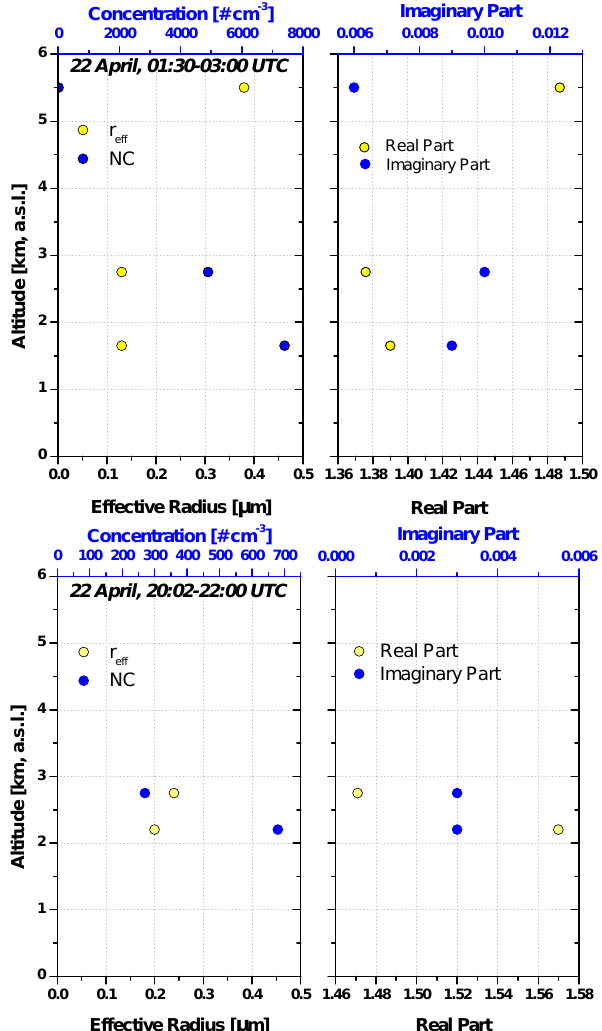
Fig. 11. Aerosol properties derived from lidar inversion code using NTUA Raman lidar data: mean effective radius, number concentra- tion, and refractive index (real and imaginary part) between 0.6 and 6km height over Athens on 22 April 2010. (a) Between 01:30 and 03:00UTC and (b) between 20:00 and